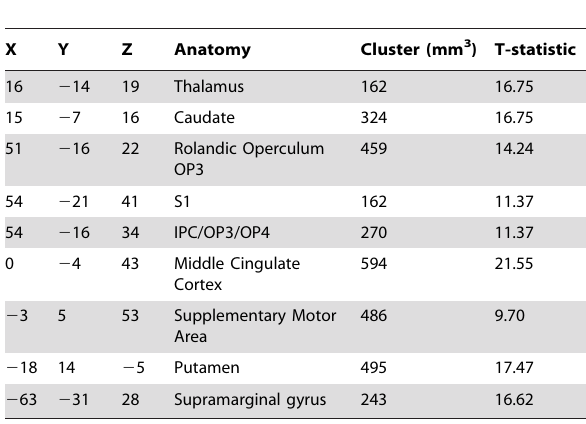
Table 2. Summary of grouped BOLD contrast signals obtained in response to